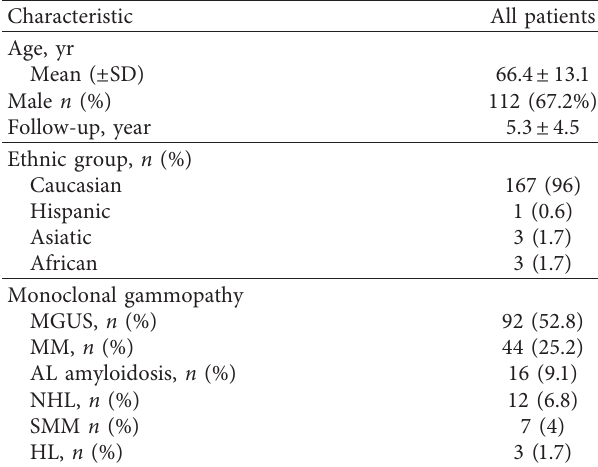
Table 1: Demographics and clinical characteristics of patients with monoclonal